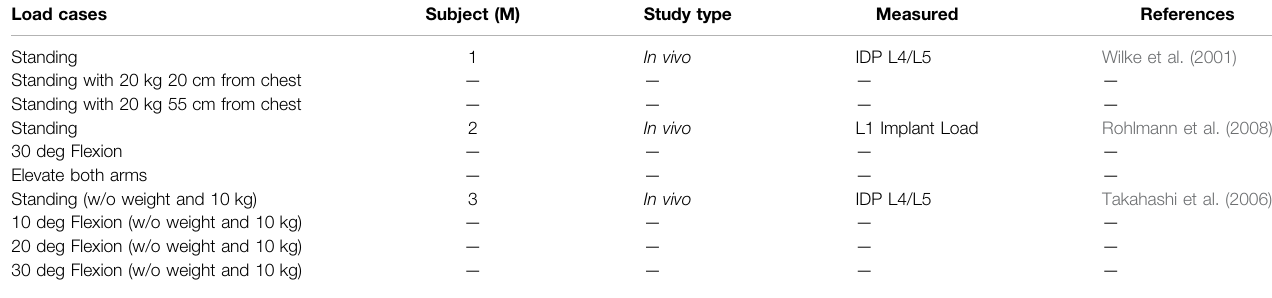
TABLE 2 | Load cases taken from in vivo studies used for validation of the model. Spinal loading was measured using intradiscal pressure (IDP) sensors (Wilke et al., 2001; Takahashi et al., 2006) or instrumented vertebral implants (Rohlmann et al., 2008). Load cases Subject (M) Study type Measured